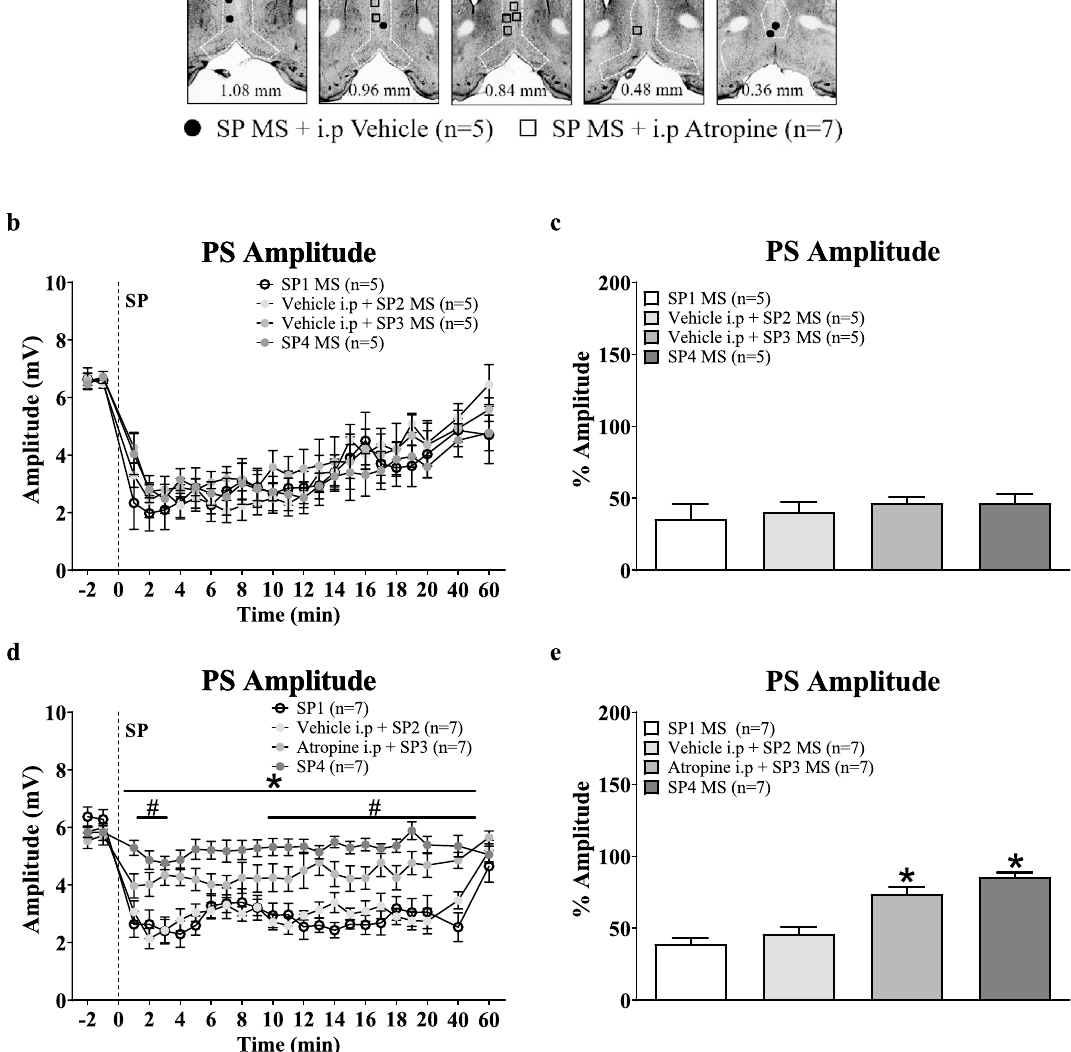
Figure 2. Intraperitoneal administration of atropine blocked Substance P (SP)-induced suppression of CA1 population spike (PS) in anaesthetised animals. SP (2 µg/µl, 0.5 µl) was microinjected into the MS 4 times (SP1, SP2, SP3, SP4) with at least 1 h between microinjections. The animals were injected intraperitoneally (i.p.) with vehicle or atropine (5 mg/kg) half an hour prior to SP2 and SP3 microinjections. Time course plots and histograms are built as in Fig. 1. ( a ) Composite of microinjection sites in the MS, built as in Fig. 1. ( b , d ) Time course graphs illustrating the effect of systemic administration of vehicle ( b ) or atropine ( d ) on the suppression of CA1 PS induced by intra-MS SP. ( c , e ) Histogram illustrating the average amplitude of PS in first 5 min after microinjection expressed as a percentage of the control PS amplitude (average of PS amplitude in − 2 and − 1 min). Note that administration of atropine ( d , e ), but not vehicle ( b , c ), blocked the suppression induced by microinjection of SP into the MS. Data are mean ± S.E.M. Significant difference (p < 0.05): ( d ) # Atropine i.p + SP2 MS vs. SP1, *SP4 MS vs. SP1 MS; two-way RM ANOVA followed by Bonferroni post-hoc test. ( e ) *vs.SP1 MS; one-way ANOVA followed by Newman–Keuls post-hoc